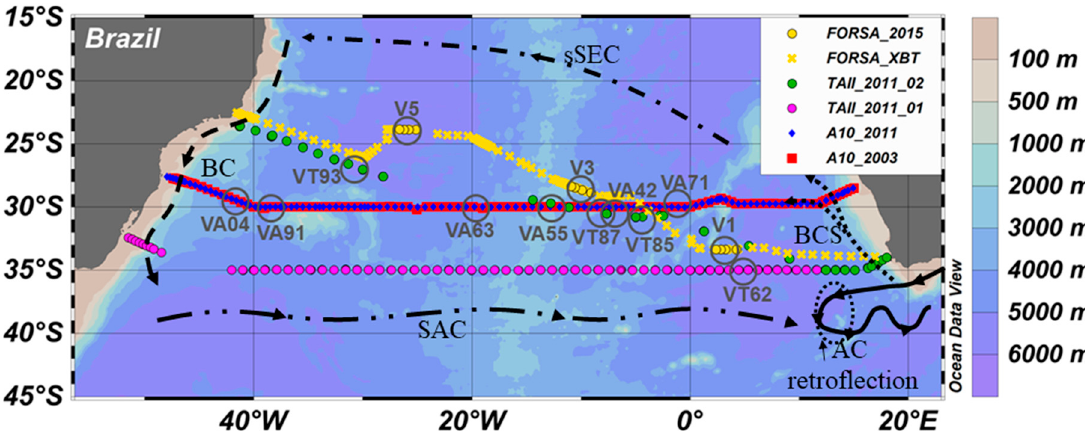
Figure 1. Map of the sampled region in the South Atlantic Ocean. The yellow crosses correspond to the expendable bathythermograph (XBT) profiles performed during the Following Ocean Rings in the South Atlantic (FORSA) cruise (FORSA_XBT). The conductivity-temperature-depth (CTD) stations are indicated by yellow dots (FORSA_2015), green dots (Trans-Atlantic II (TAII)_2011_02), purple dots (TAII_2011_01), blue diamonds (A10_2011), and red squares (A10_2003). The gray circles indicate the approximate positions at which the eddies were sampled: V1, V3, and V5 (FORSA_2015); VT62 (TAII_2011_01); VT85, VT87, and VT93 (TAII_2011_02); VA42, VA63, and VA91 (A10_2011); and VA04, VA55, and VA71 (A10_2003). The black lines represent the main currents of the surface circulation, which are the Benguela Current System (BCS, dotted line), southern branch of the South Equatorial Current (sSEC, dot-dashed line), Brazil Current (BC, dashed line) and South Atlantic Current (SAC, dot-dot dashed line). The Agulhas Current (AC, continuous line) and Agulhas Current retroflection zone (black dotted ellipse) are also indicated. The bottom bathymetry is represented by color shadings.